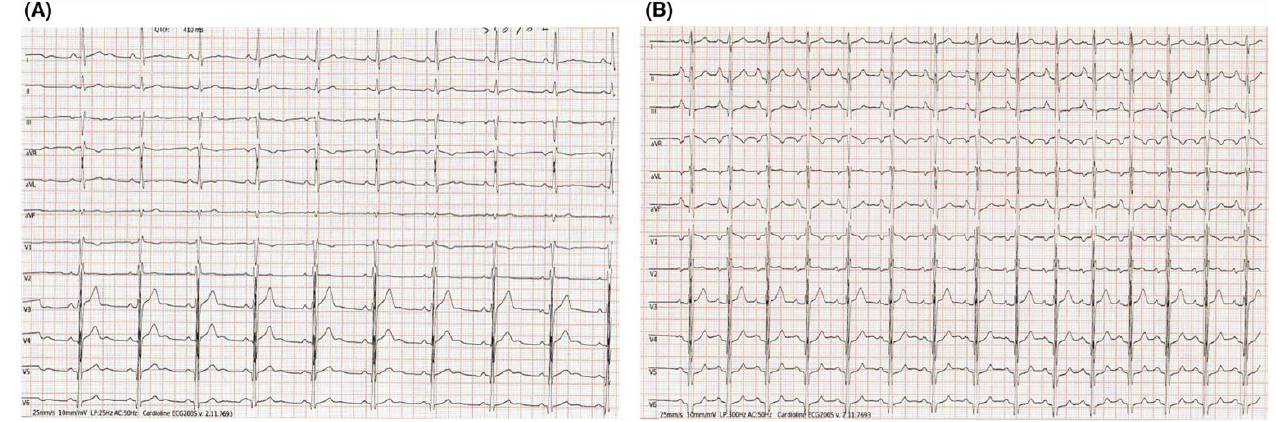
Figure 1. Acute ECG changes reflecting right heart overload. ECG of a top-level competitive athlete the day before ( A ) and immediately after ( B ) running a 50 km ultramarathon. After the race, the ECG showed higher P- wave voltages and a rightward shift in the QRS axis. Adapted from D’Ascenzi et al. [10].